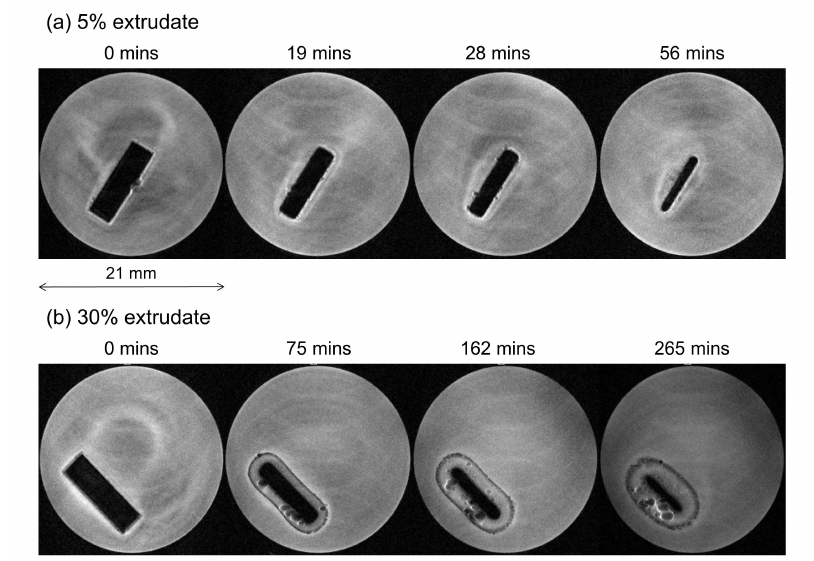
Figure 5. Magnetic resonance images (first experiment) showing the changes as a function of time in one cross sectional slice of the extrudates containing 5% ( a ) and 30% ( b ) of bicalutamide.